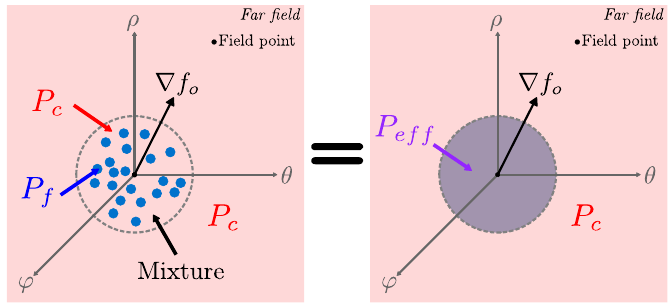
Figure 4. Schematic representation of Maxwell’s theory. A composite sphere comprised of spherical particles (phase f ) in a matrix (phase c ), immersed in an infinite matrix of phase c .